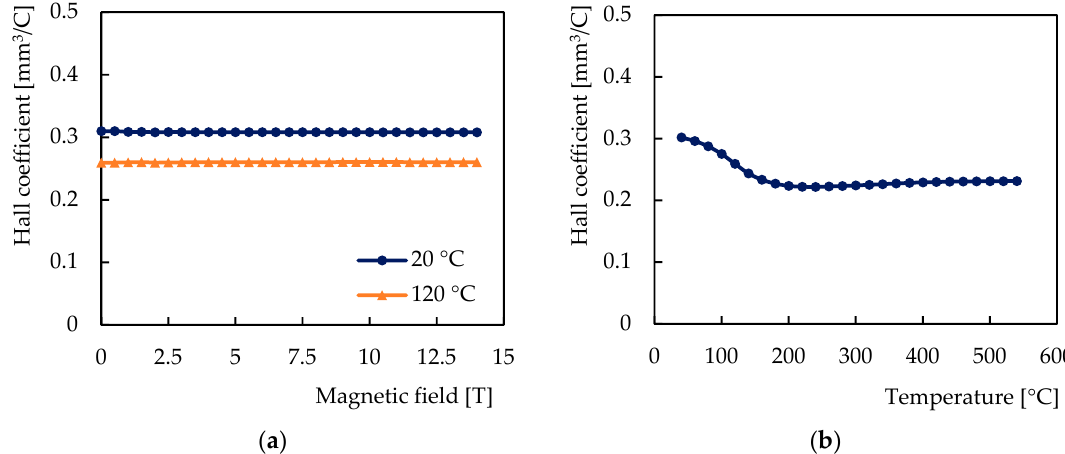
Figure 7. Hall coefficient of chromium of the sensitive nanolayer: ( a ) Dependence on the magnetic field at 20 °C and at 120 °C; ( b ) Dependence on the temperature in the magnetic field of 200 mT.